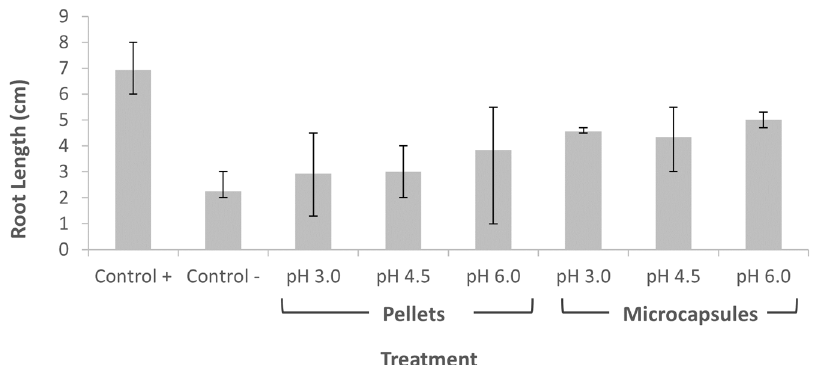
Figure 10. Phytotoxicity test. Milli-Q water and acetaminophen with milli-Q water (1:1 dilution factor) were the positive and negative controls, respectively. Final volume for each replica was 2 mL. Error bars correspond to the absolute error.